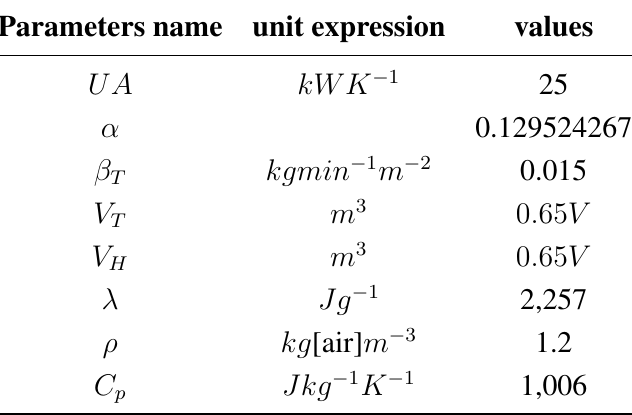
Table 1. Greenhouse model